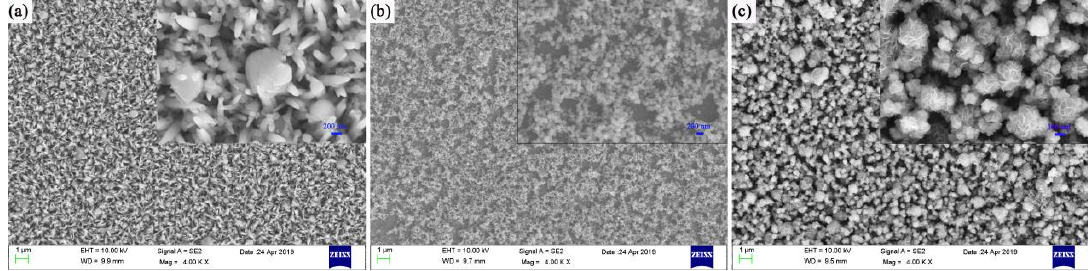
Figure 2. SEM images of the sample at different temperatures under the conditions of reaction time of 20 h and precursor amount of 30 mg. ( a ) Reaction temperature is 180 °C; ( b ) reaction temperature is 200 °C; and ( c ) reaction temperature is 220 °C.